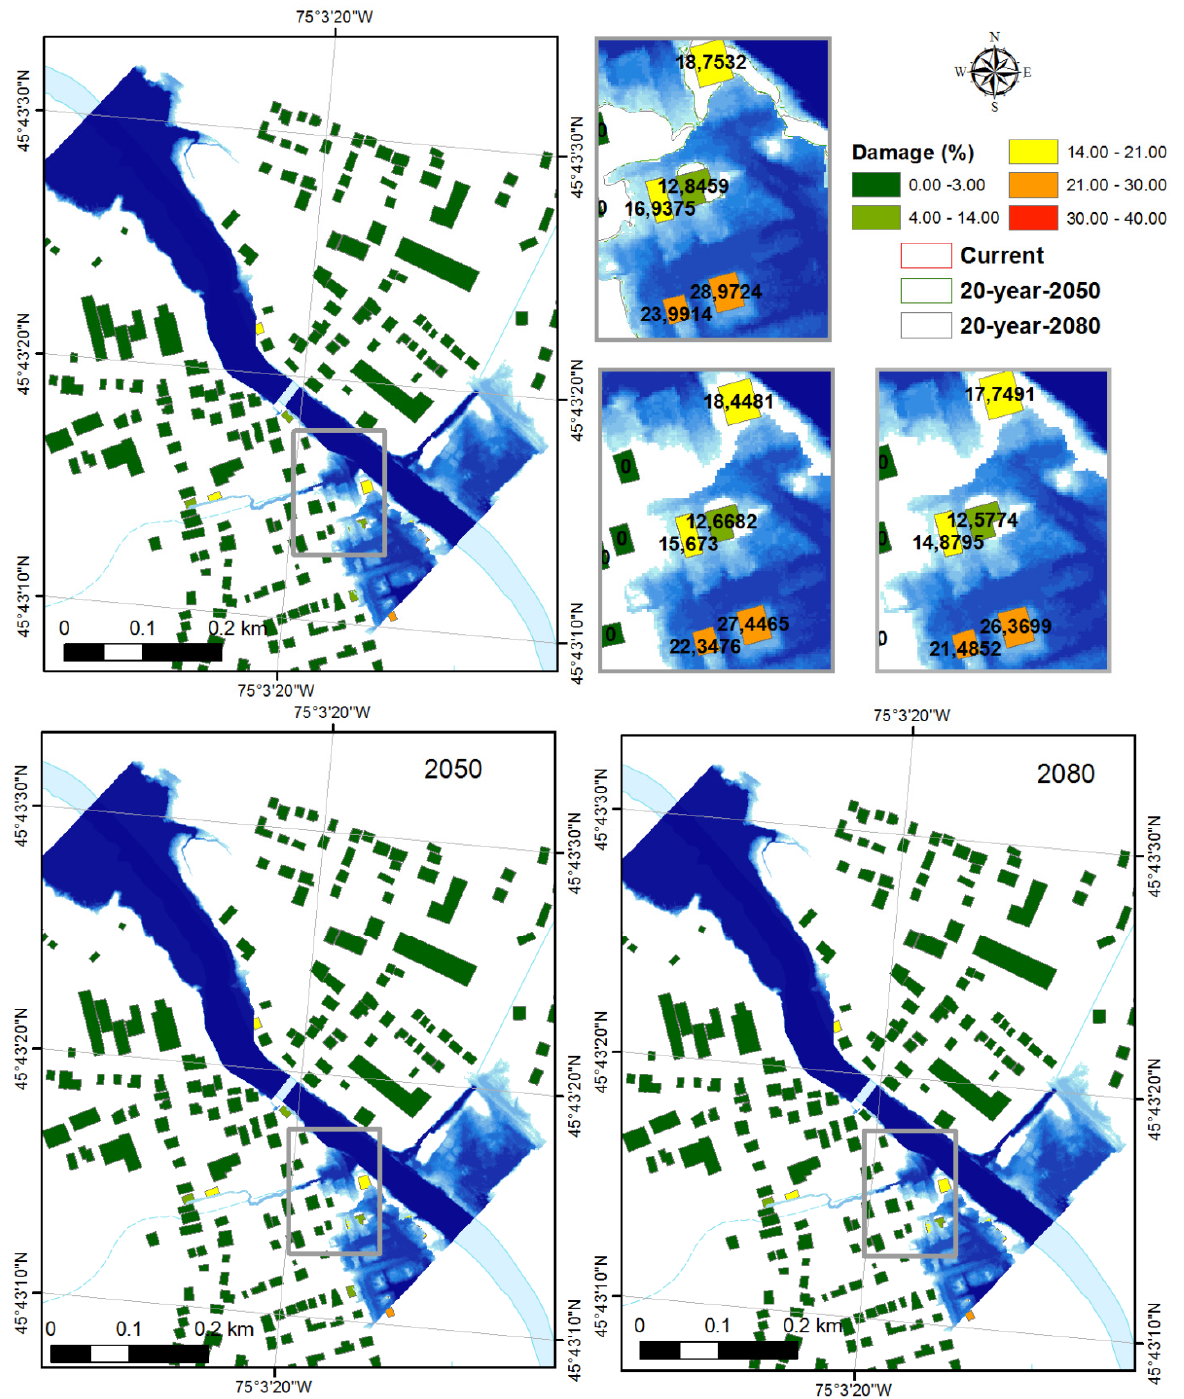
Figure A10. Projected monetary damage map expressed in percentage for a 20-year return period with current, 2050, and 2080 (RCP 8.5). Case: St-Andre-Avellin.